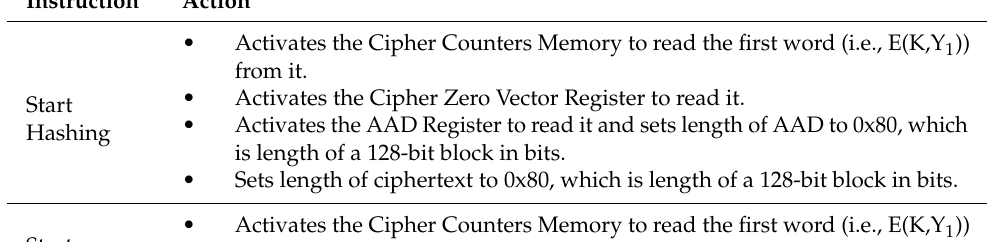
Table 4. The actions performed by the control unit component to support the hashing